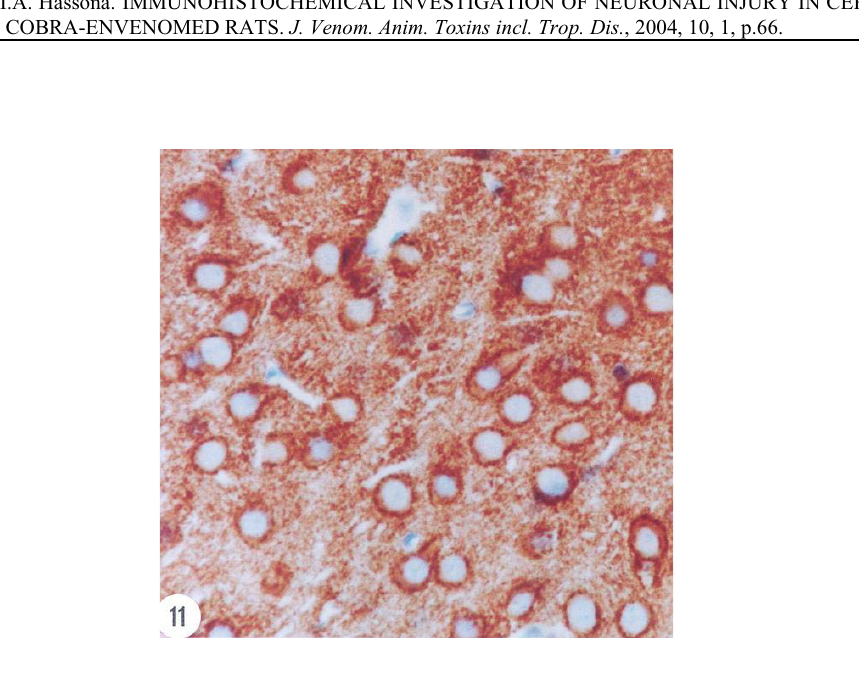
Figure 11. Neurons of cerebral cortex 72 hr after low dose envenoming showing intense SYN reactivity. (X400)